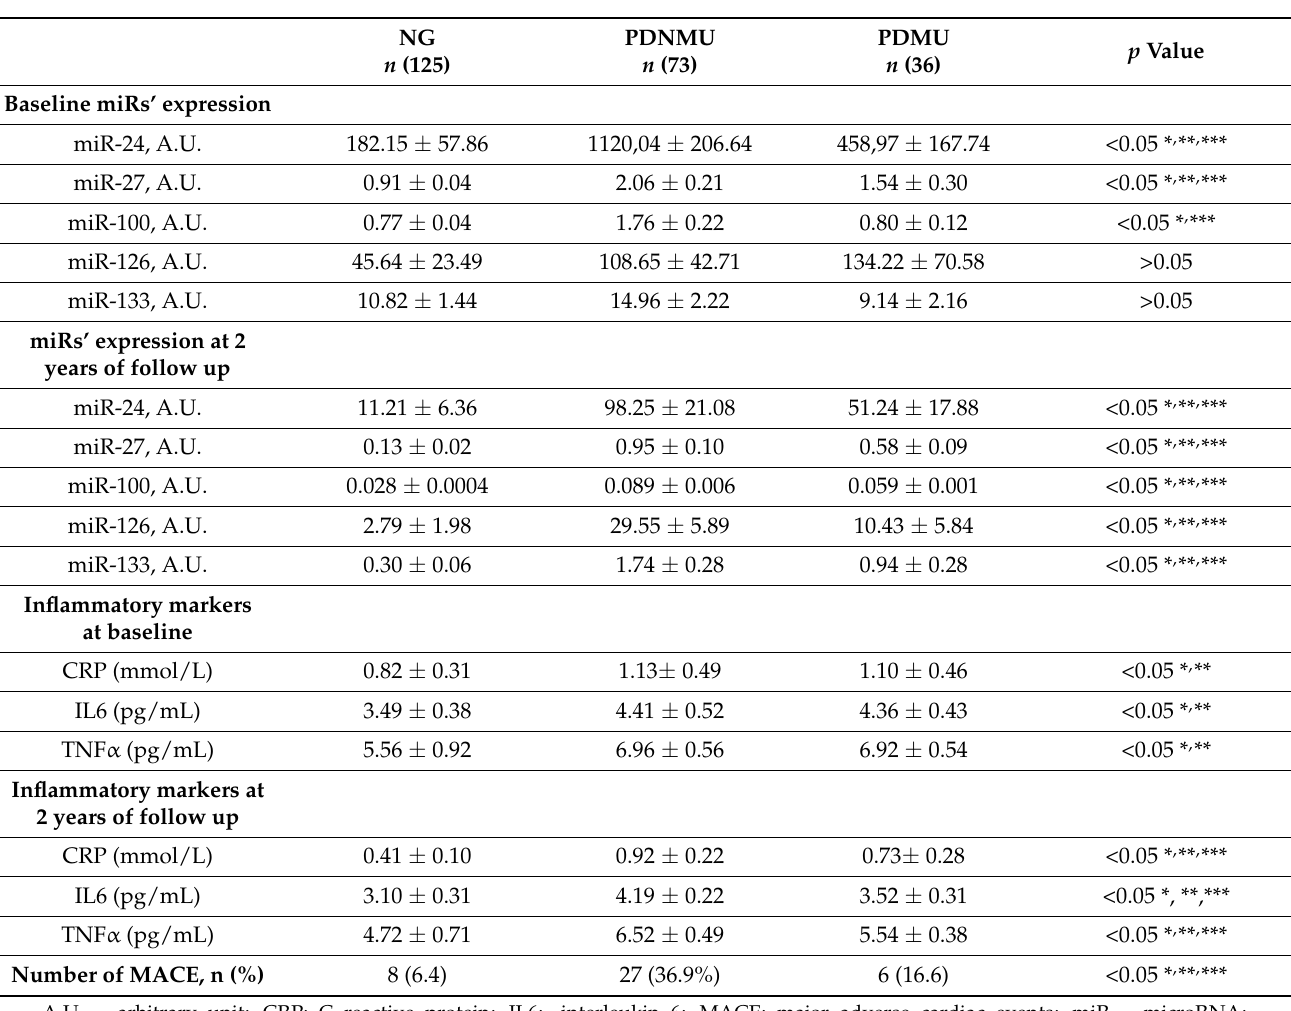
Table 2. microRNAs (miRs) expression at baseline and at 2 years of follow-up in normolgycemics (NG) versus pre-diabetics non-metformin-users (PDNMU) versus pre-diabetics metformin-users (PDMU), and major adverse cardiac events (MACE) at 2 years of follow-up in normolgycemics (NG) versus pre-diabetics non-metformin-users (PDNMU) versus pre-diabetics metformin-users